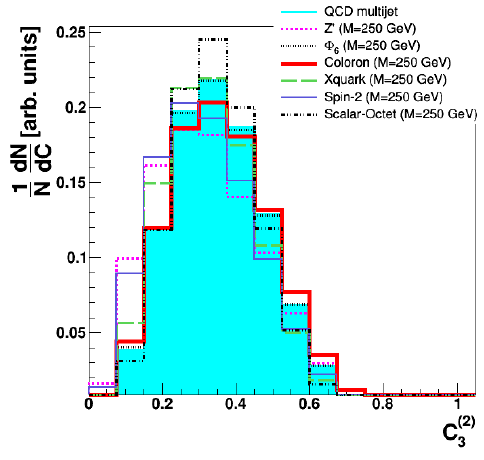
Figure 3 . The double ratio distributions for C (2)